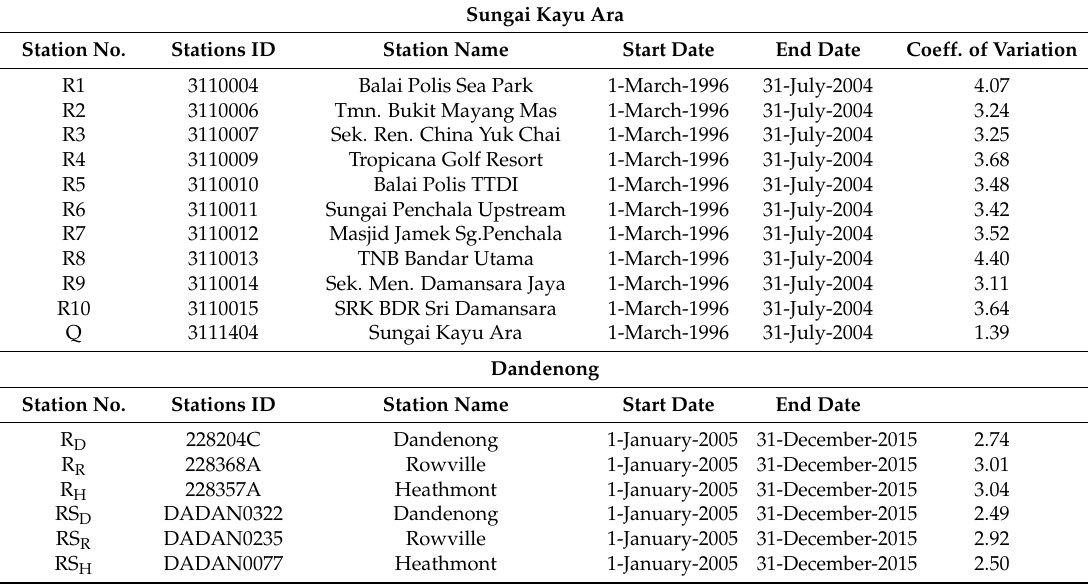
Table A1. Detail of rainfall and flow stations and their recorded data in the two catchments of this study. Sungai Kayu